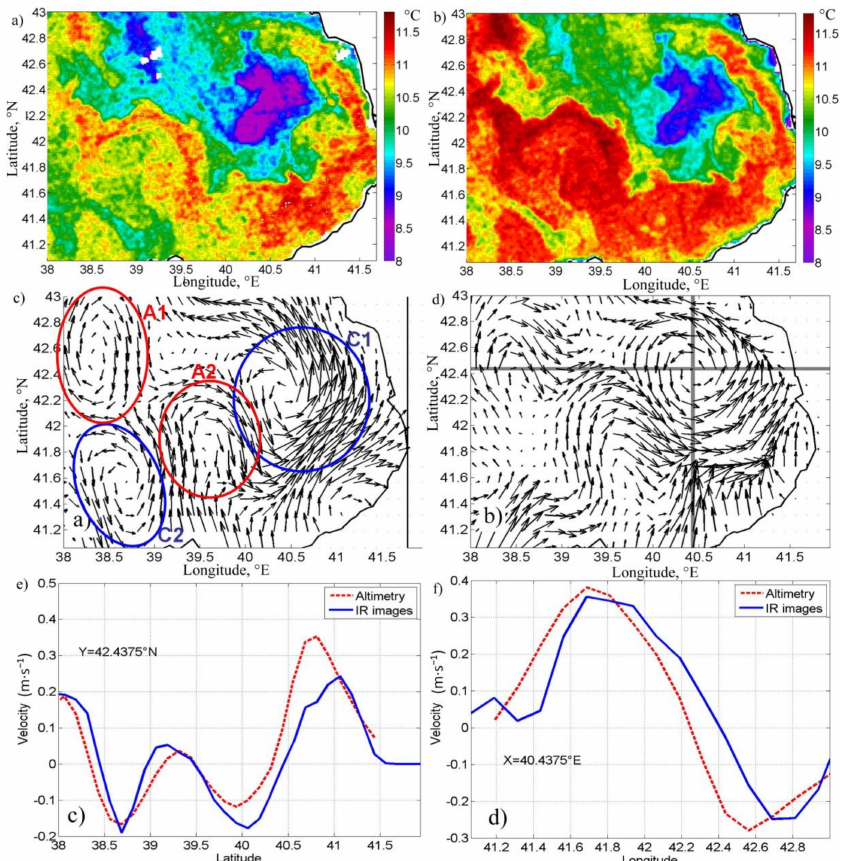
Figure 4. ( a , b ) AVHHR SST at 13 January 2005 08:13 ( a ); 13 Jan 2005 14:49 ( b ); ( c , d ) Surface current calculated for 13 January 2005 from altimetry ( c ), from IR images (solid line—sections) ( d ); ( e , f ) meridional section of u ( e ), zonal section of v ( f ) (red line—altimetry; blue—IR